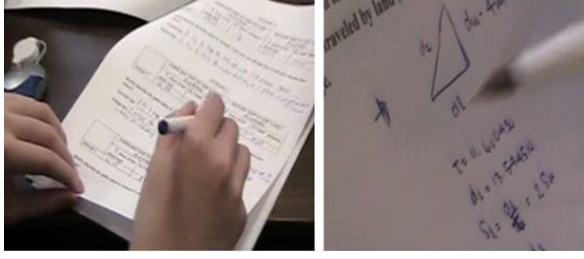
Figure 2. Working with guiding–reflecting journal.